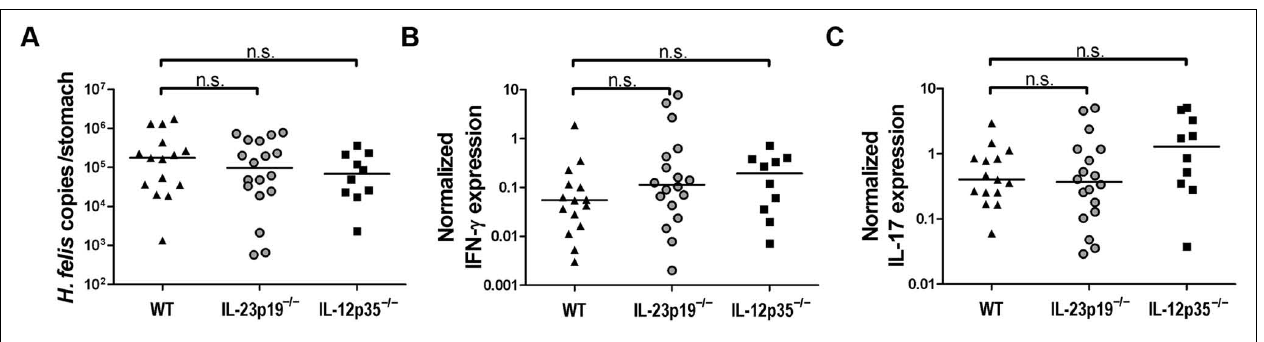
FIGURE 2 | IL-23p19 − / − and IL-12p35 − / − mice do not differ significantly from wild type animals with respect to H. felis infection control. (A) Colonization levels as determined by quantitative PCR of the H. felis flaB gene of wild type (WT; n = 15), IL-23p19 − / − ( n = 18), and IL-12p35 − / − ( n = 10) mice infected with H. felis for 3 months. Medians are indicated by horizontal lines; each symbol represents one